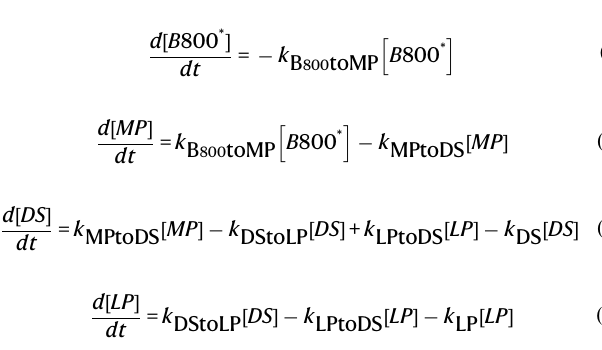
Table 1 | Results of modeling for the strong coupled system